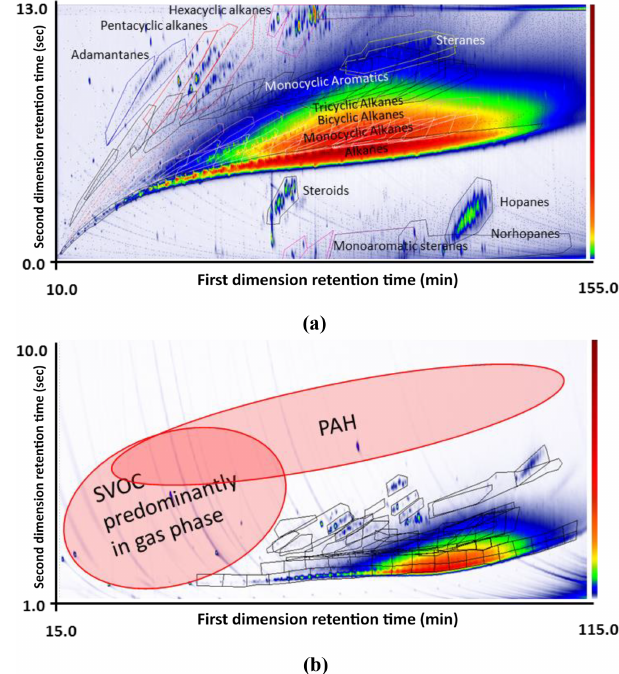
Figure 3. A chromatogram (with 70eV ionization mass spectrom- etry) of lubricating oil (5W30) (a) with labelled compound classes, using a methodology specific for characterizing the composition of lubricating oil, (b) using methodology developed for characterizing particulate-phase emissions from diesel engine exhaust. Polygons drawn around sections of the chromatograms indicate compounds with different molecular masses within compound